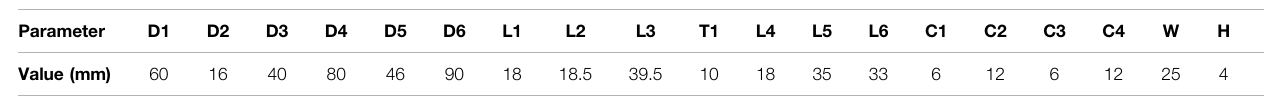
TABLE 2 | Geometrical sizes of the piezoelectric vibrator.